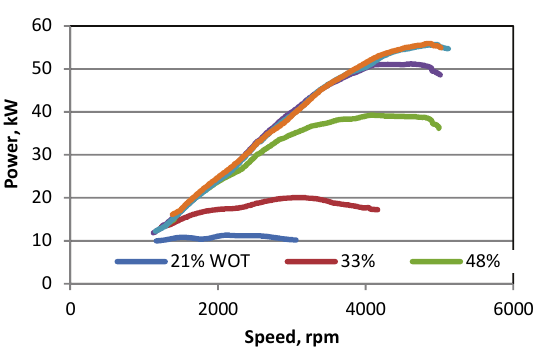
Fig. 5. Engine power for different WOT. Fuel LPG/DME: 91/9% The chart showing the maximum values of the measured engine power (Fig. 6) indicates that with the engine load drop, the fuel composition changes to give the maximum power (red line in the graph). The change in fuel composi- tion consists in increasing DME's share. For the analysis of maximum torque values (Fig. 8), there is a similar tenden- cy, although not so pronounced. The power and torque measured on the wheels of the vehicle (Fig. 9 and 10) also show that, with less engine load, an increase of the DME share has a beneficial effect to the performance of the vehi- cle. This area is marked on the chart.